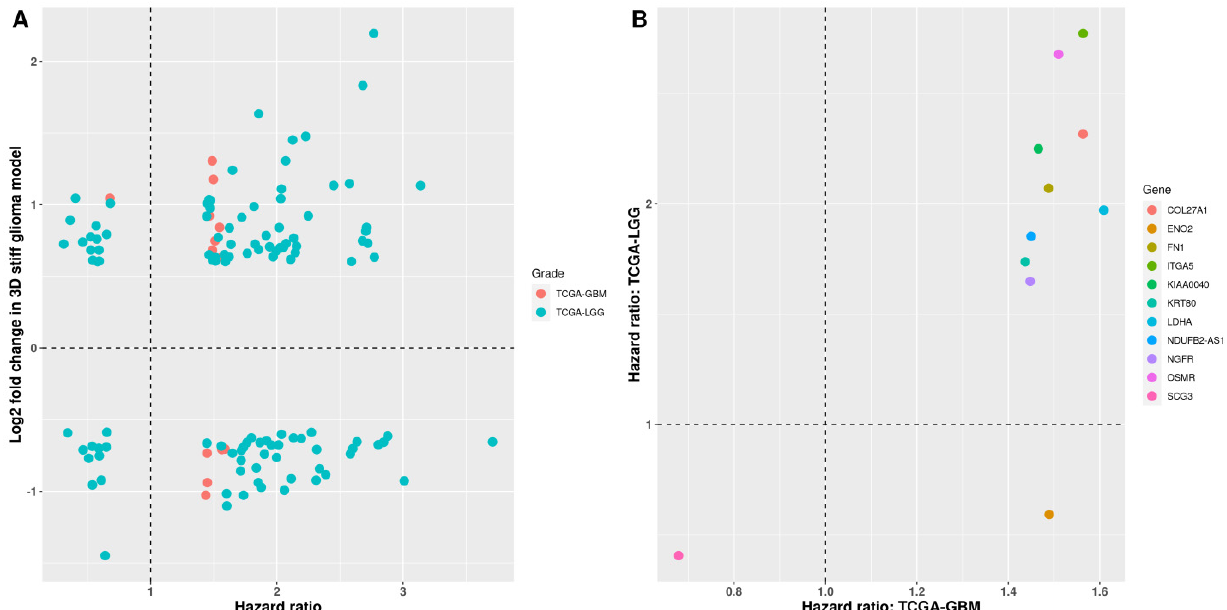
Figure 4. Comparison of hazard ratios between high − and low − grade gliomas. ( A ) Scatterplots of stiffness − dependent gene expression and corresponding hazard ratios for TCGA − GBM and TCGA − LGG. ( B ) Common stiffness − dependent prognostic genes between TCGA − GBM and TCGA − LGG.